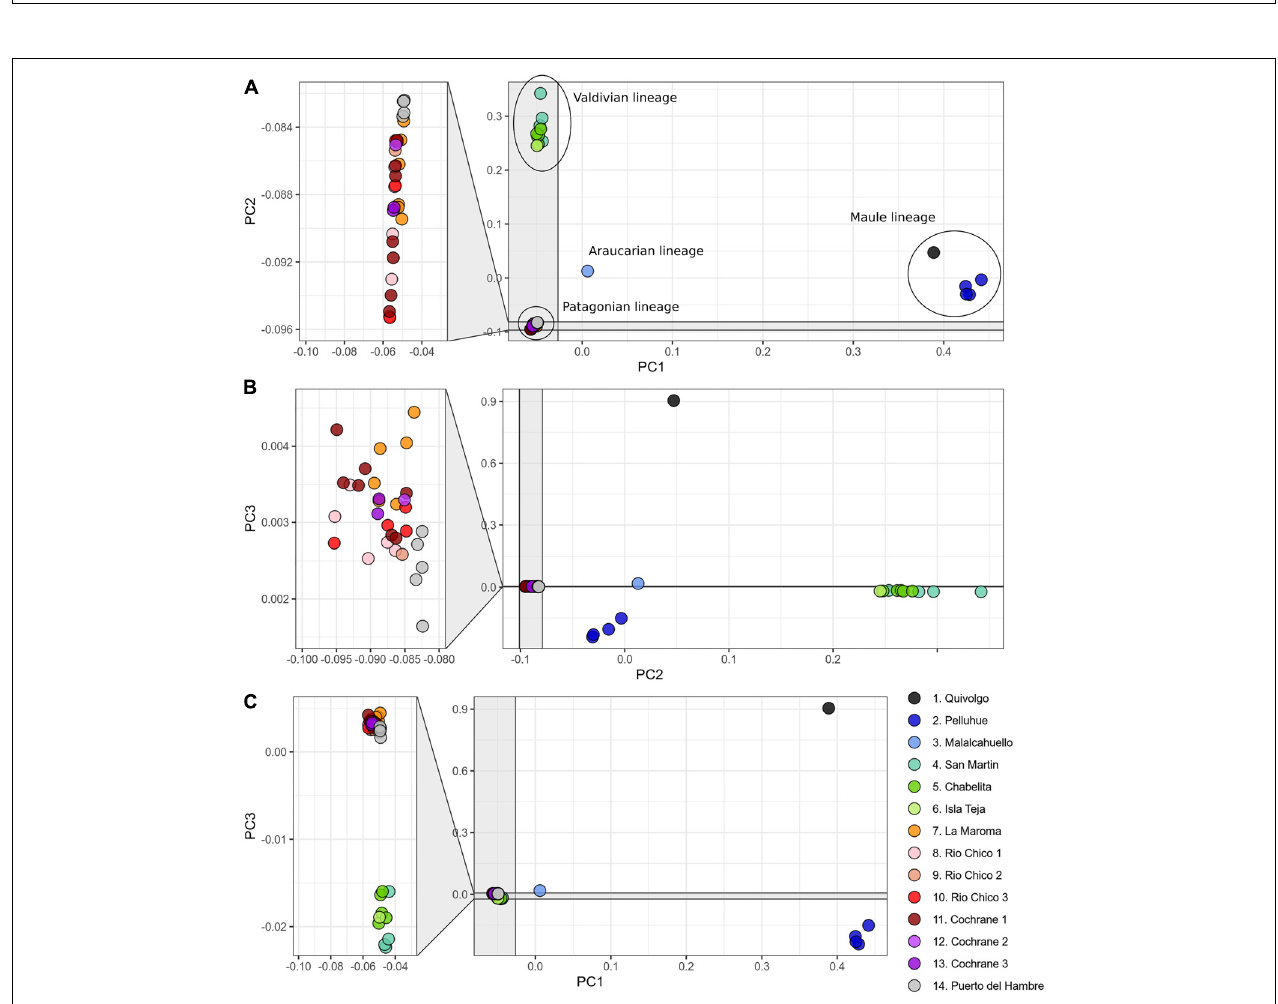
FIGURE 3 | Principal component analysis based on 119,226 SNP loci of 46 specimens of Abrothrix hirta. Each specimen was colored according to the locality at which it was collected as indicated in Figure 1 (details in Table 1 ). Lineages found in the phylogenetic analysis ( Figure 1 ) are indicated with the ellipses. (A) PC1 vs PC2; (B) PC2 vs PC3; (C) PC1 vs